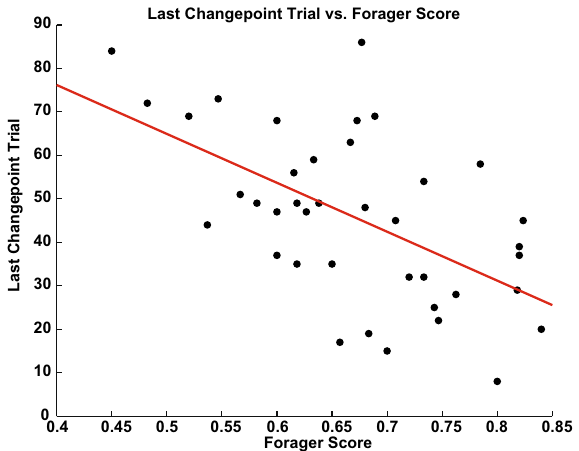
Figure 6. For human participants, the information forager score F s predicts the speed of learning. Each point is a single subject. Red line: OLS regression (β slope = − 112.54 ± 26.78 trials/a.u. forager score, p <